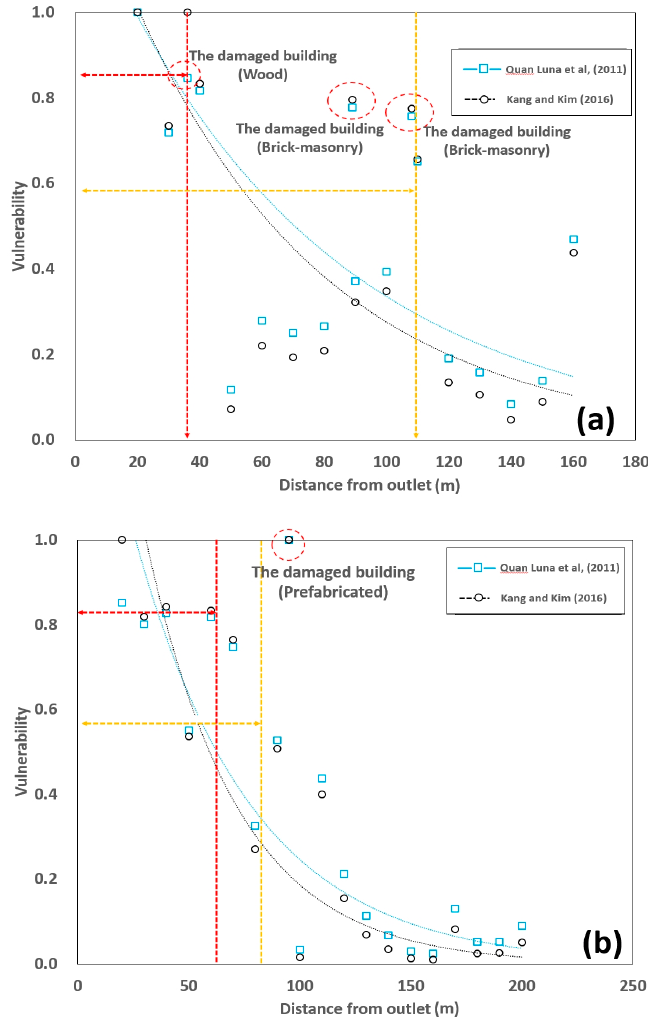
Figure 7. Distribution of vulnerability indexes by construction material with changing distance from an outlet and analysis of minimum safety distance. The vertical dotted lines in different colors indicate the minimum safety distance at the point where it becomes the same as or lower than the maximum vulnerability point for each material (horizontal dotted line in red for vulnerability index of wood (0.84) and in yellow for vulnerability index of brick masonry (0.58)). ( a ) Site A for Chuncheon-shi area and ( b ) Site B for Cheongju-shi area.